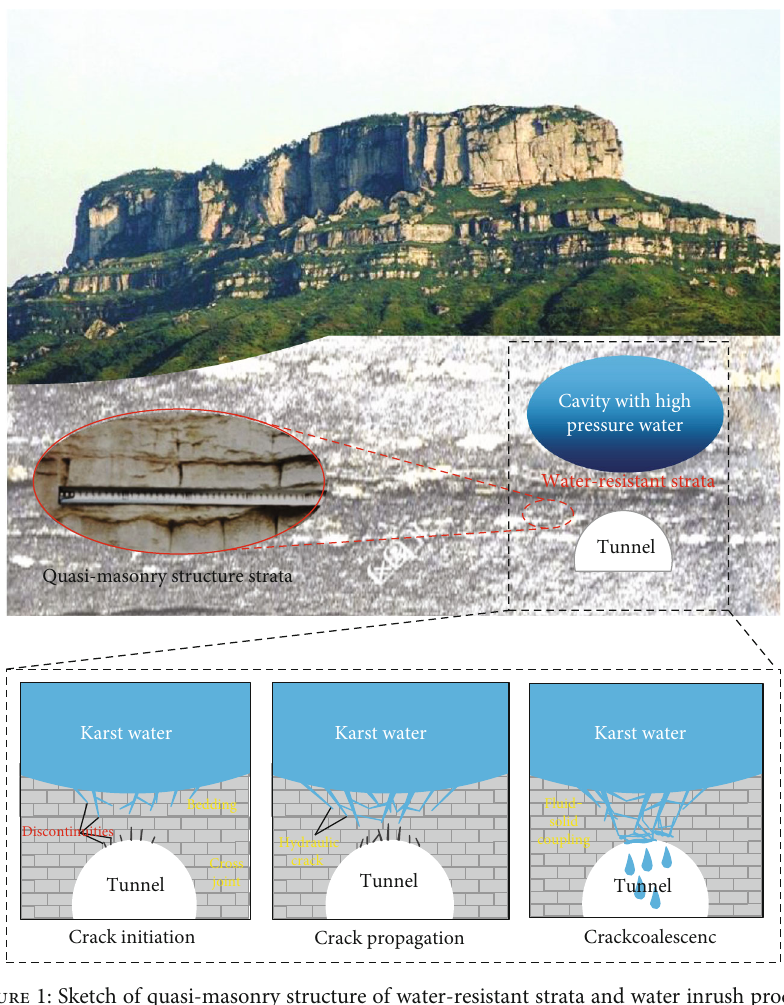
Figure 1: Sketch of quasi-masonry structure of water-resistant strata and water inrush process.